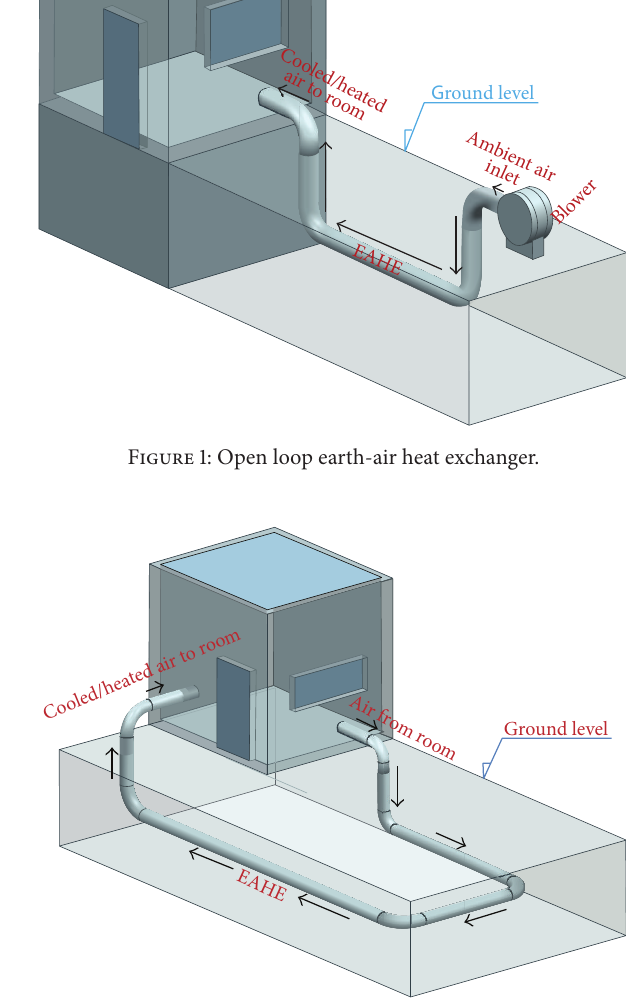
Figure 2: Closed loop earth-air heat